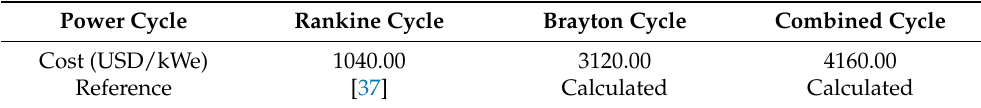
Table 3. Efficiency and costs for Rankine, Brayton and combined cycle for electricity generation.